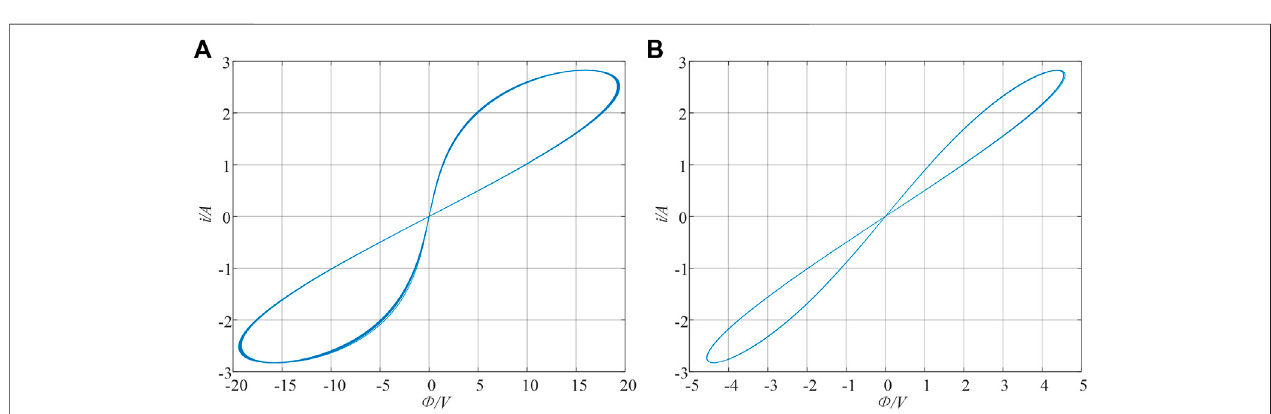
Frontiers in Physics |